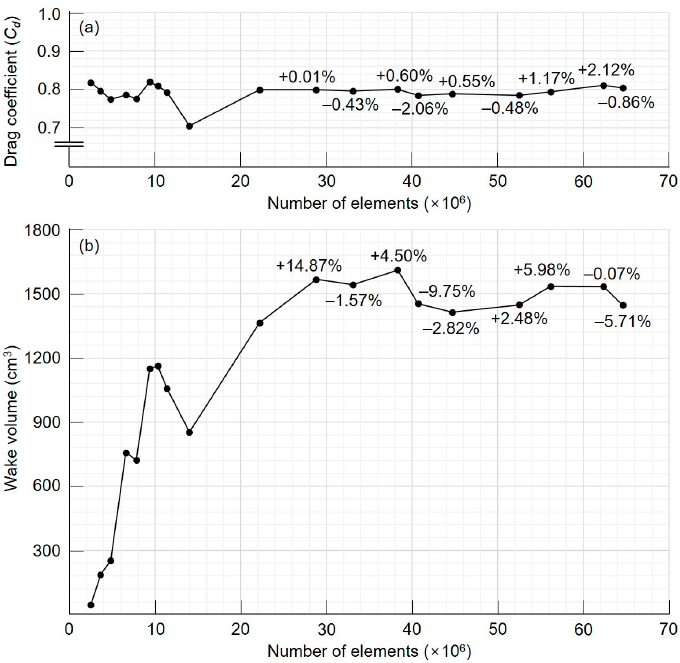
Figure 5. Mesh independence: ( a ) drag coe ffi cient and ( b ) wake volume.